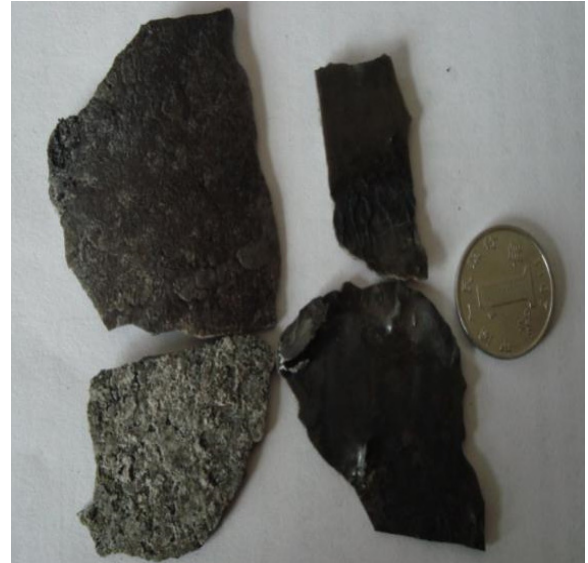
Figure 1. Samples of solidified flux films.